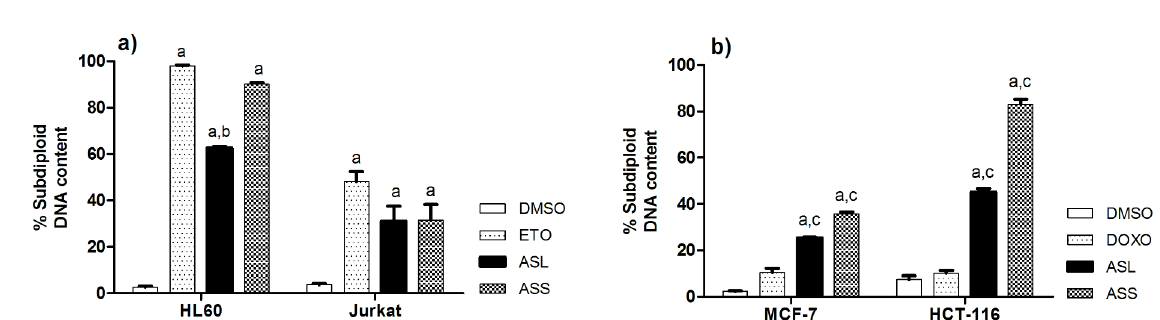
Figure 8 - Effect of methanolic extracts of Annona squamosa seeds (ASS) and leaves (ASL) on DNA content of tumor cell lines. HL-60, Jurkat, MCF-7 and HCT-116 cells were incubated with samples (20 µg/mL) or with control (0.5% DMSO) for 24 h. DNA content was assayed by PI stain and flow cytometry analysis. A) Etoposide (ETO - 8 µg/mL) and B) doxorubicin (DOXO - 5 µg/mL), positive controls are demonstrated. Each data point represents mean ± SD from at least two independent experiments performed in duplicate. a Statistically different from negative control (0.5% DMSO). b Statistically different from positive control (etoposide) c Statistically different from positive control (doxorrubicin) (ANOVA followed by Bonferroni, P <